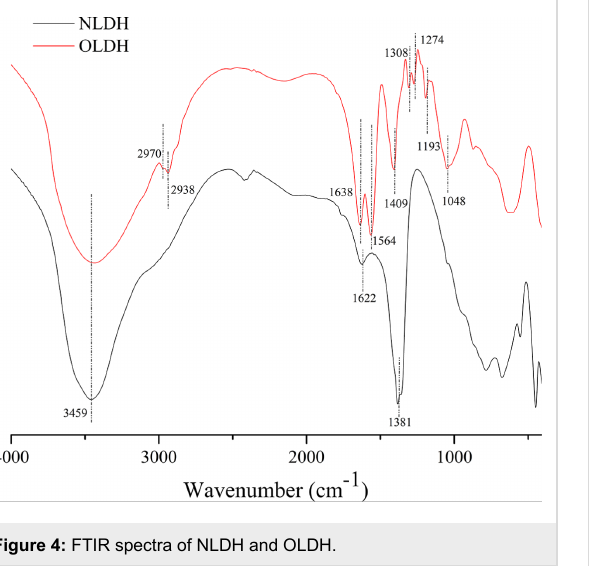
Figure 4: FTIR spectra of NLDH and OLDH.